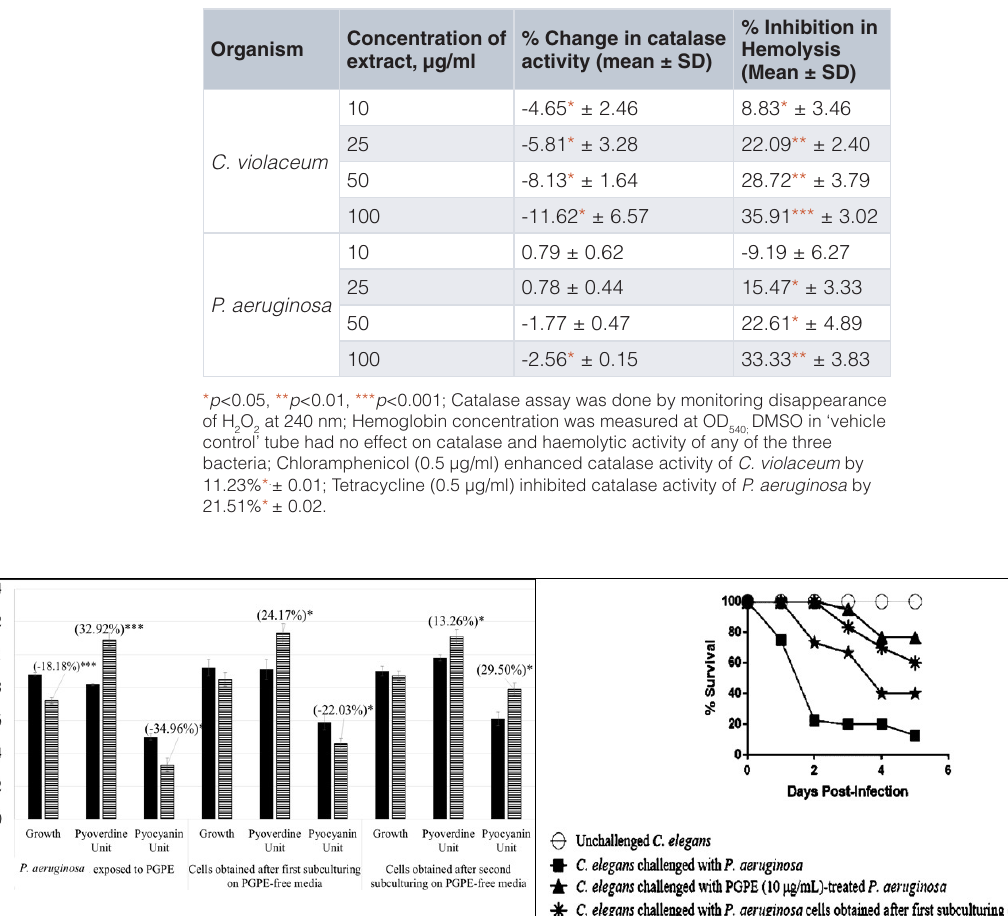
Table 1. Effect of PGPE on catalase and haemolytic activity of test